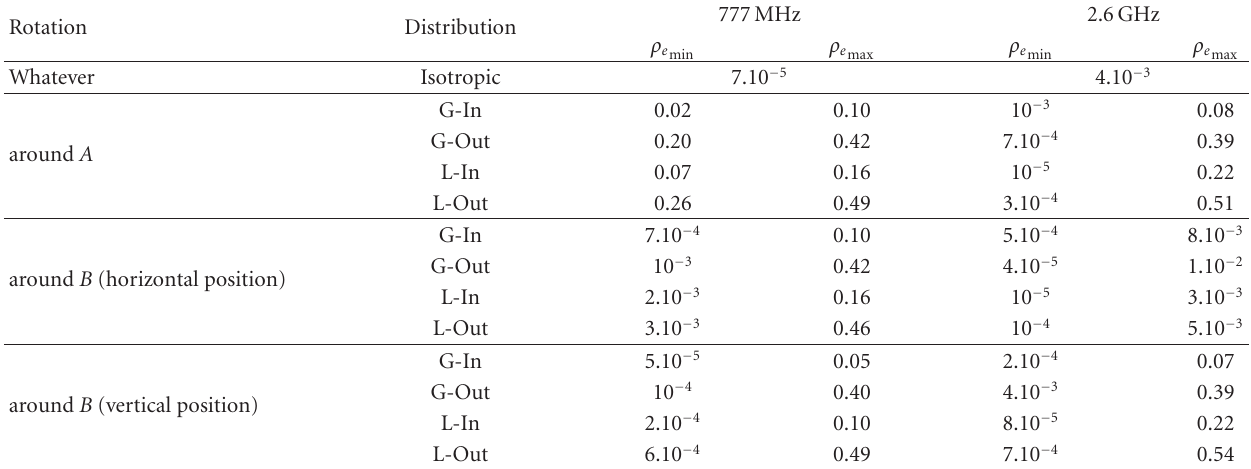
Table 1: Coe ffi cients of correlation for the two bands for all environments of the proposed structure. Rotation